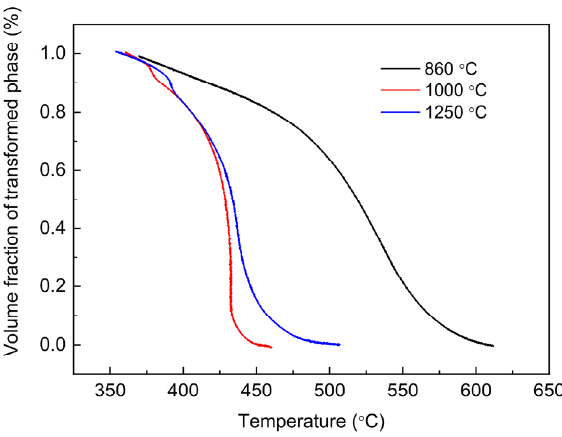
Figure 5. Kinetic curves of bainite transformation in the experimental steel treated with different austenitizing temperatures.